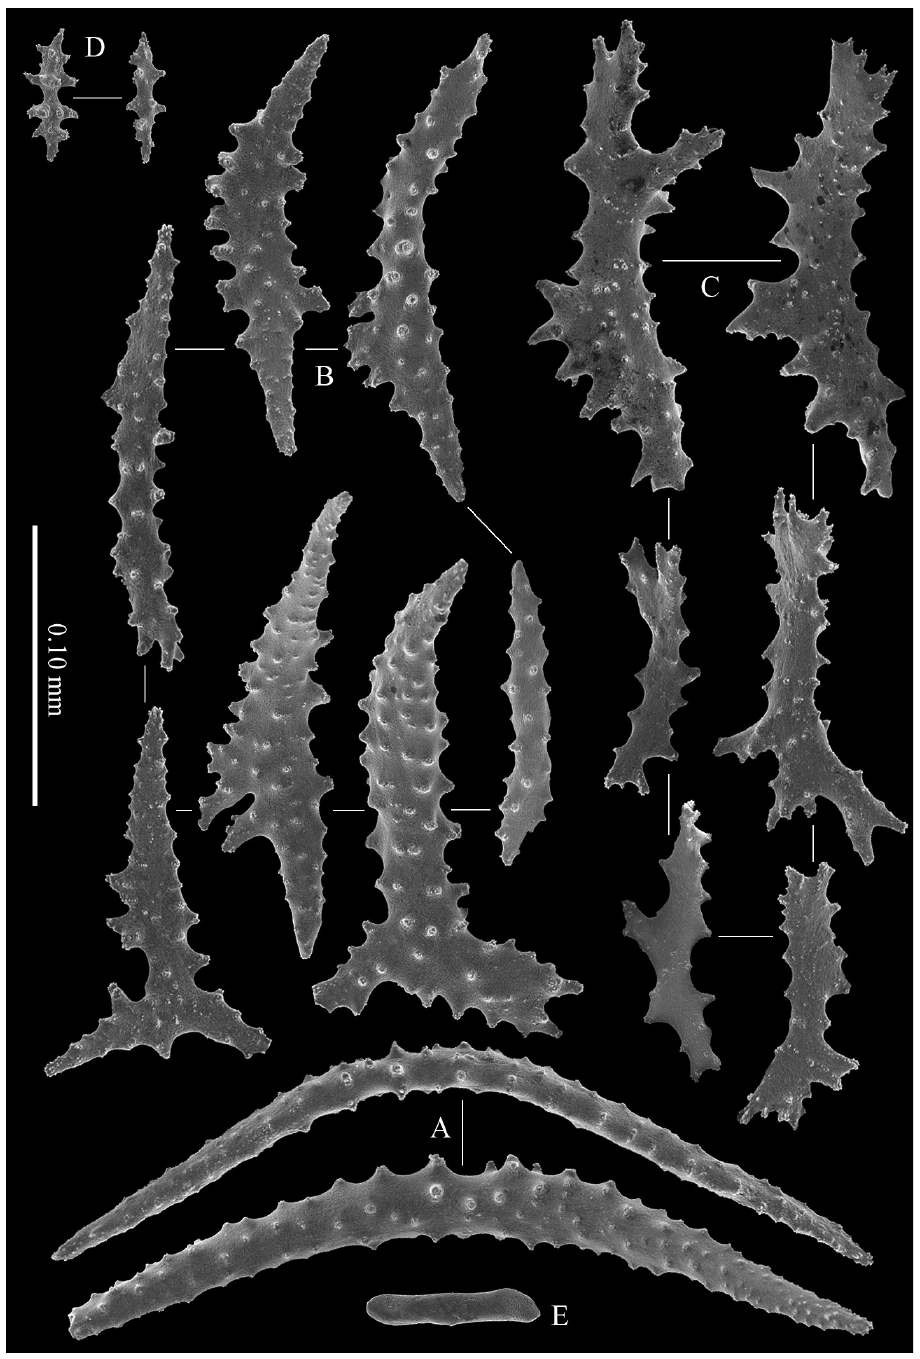
Figure 6. Polyp sclerites of Melithaea davidi sp. n., holotype, RMNH Coel. 42122; A collaret sclerites B point sclerites C tentacle sclerites D Pharynx sclerites E node